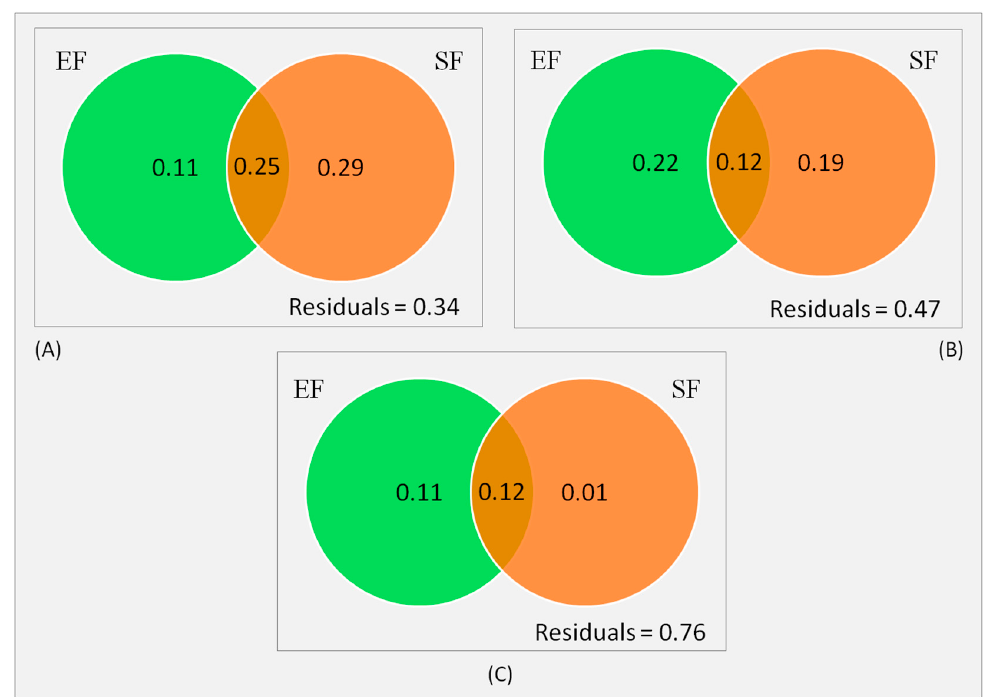
Figure 7. Results of the variation partitioning for metacommunity of macroinvertebrates into pure environmental factors (EF), pure spatial factors (SF), and their shared fractions for each period, ( A ) = 2017, ( B ) = 2018, and ( C ) = 2019. The entire fractions are based on R 2 adjusted values indicated as proportions of the overall variation. The residuals (unexplained variance) are displayed in the lower right corner.